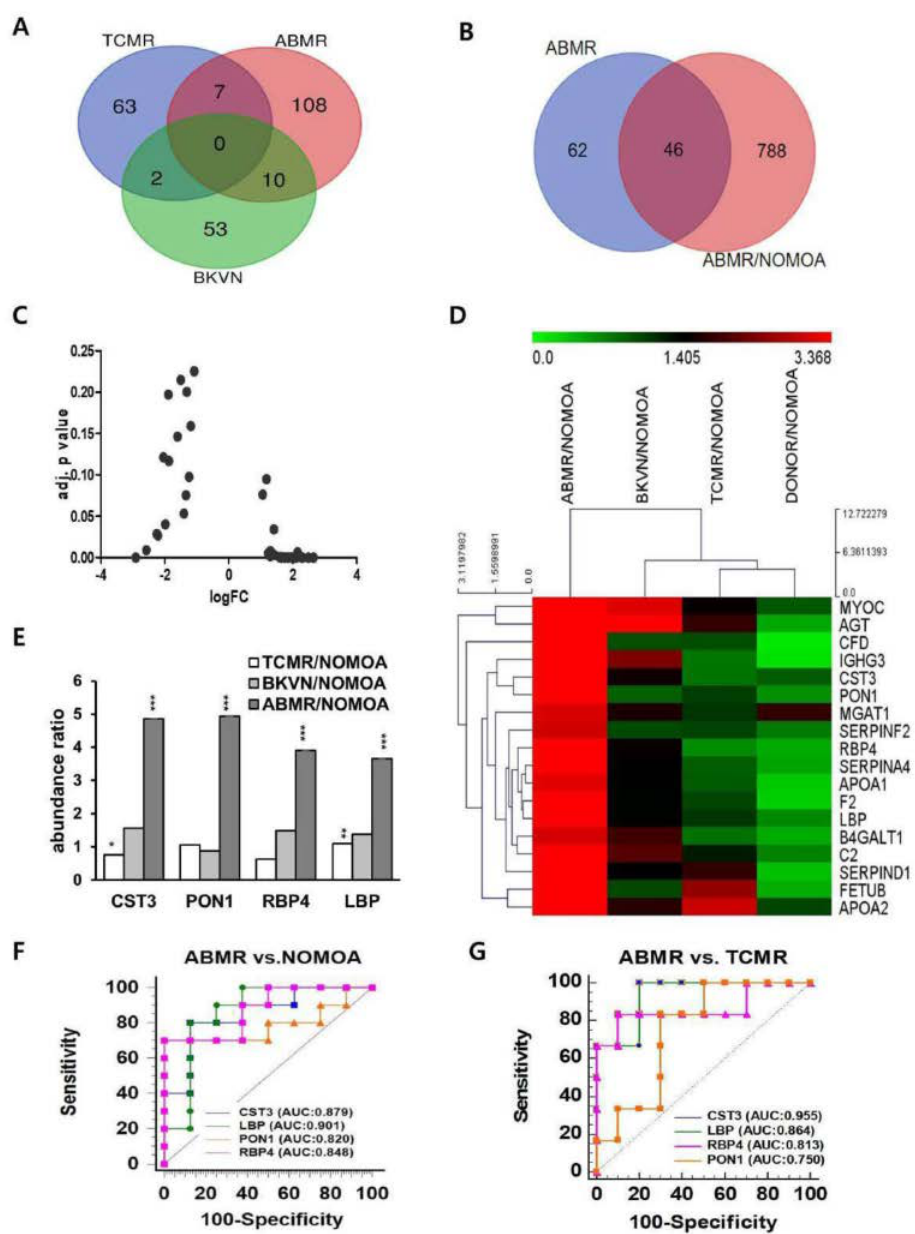
Figure 3. Discovery of proteomic biomarker candidates using proteomic analysis. ( A ) A total of 262 exosomal proteins were identified, of which 125 were identified in ABMR. ( B ) Forty − six proteins in the overlapping portion of ABMR and ABMR/NOMOA were selected as biomarker candidates for ABMR. (ABMR = 12, TCMR = 8, BKVN = 5). ( C ) A volcano plot was constructed using fold − change (LogFC) values and adjusted p -values for abundance ratio. The logFC > 0 represents up-regulated genes and logFC < 0 means downregulated candidates. ( D ) Heatmap showing the top 18 differentially expressed genes in upregulation after excluding missing values. The differentially expressed genes were selected on the basis of FC(log2) >1.5 and adj p < 0.001. ( E ) The relative expression levels of top 4 candidates in the ABMR and other pathologic groups for abundance ratio. * p < 0.05 ** p < 0.01 *** p < 0.001. ( F , G ) The area under the receiver operating characteristic curve was calculated to discriminate ABMR from other groups in the discovery cohort. ABMR, antibody − mediated rejection; NOMOA, no major abnormality. TCMR, T cell − mediated rejection; BKVN, BK virus nephropathy; AUC, area under the ROC